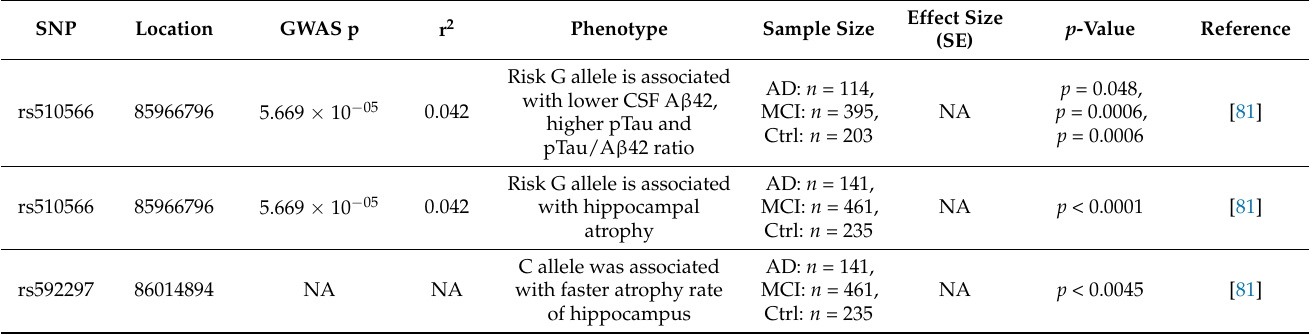
Table 1. Association between PICALM SNPs and AD-related phenotypes. The location of SNPs is based on GRCh38. Linkage disequilibrium to rs3851179 is denoted as r 2 . Effect size shows beta coefficients. SE: standard error. NA: non-available. Hip: hippocampus. EC: entorhinal